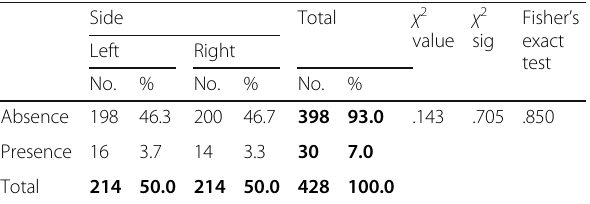
Table 4 Incidence of RMC in each side Side Total χ 2